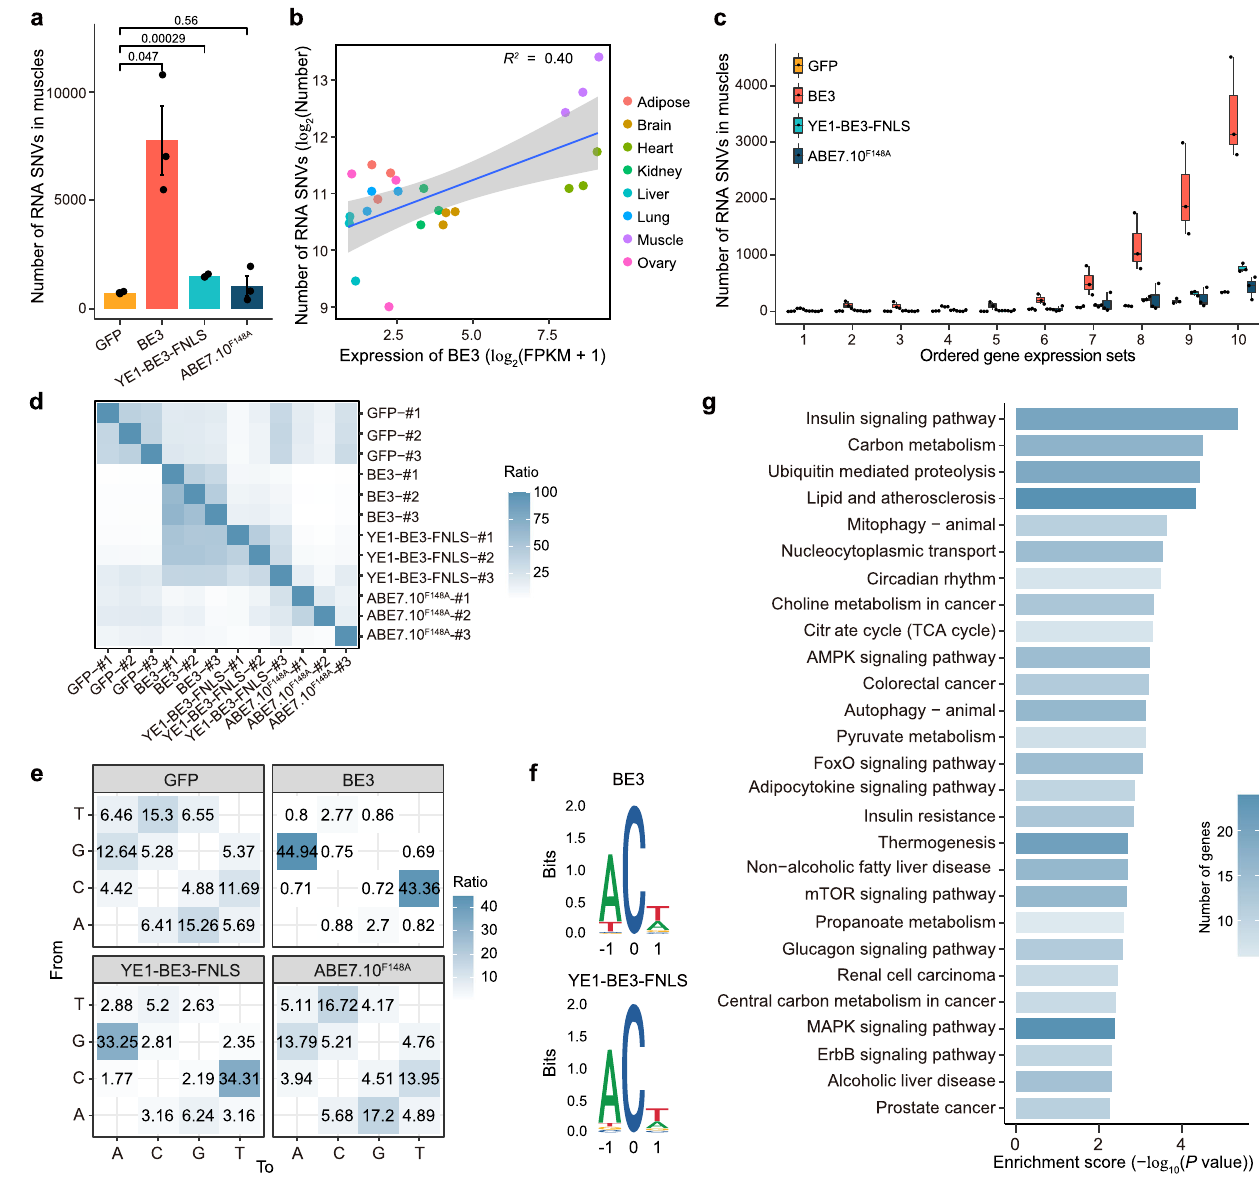
Fig.3|RNAoff-targetmutationsintheGFP,BE3,YE1-BE3-FNLSandABE7.10 F148A transgenicmice.a ComparisonofthenumbersofRNASNVsinmusclesoftheGFP, BE3, YE1-BE3-FNLS and ABE7.10 F148A transgenic mice. Data are presented as mean±SEM ( n =3). P values were calculated by two-sided unpaired t -test. b Correlationsbetweenthe numbersof RNASNVsand the expressionlevels of BE3 in diverse tissues of the BE3 transgenic mice. c Correlations between the numbers of RNASNVsand gene expression levels in the muscles ofGFP, BE3, YE1-BE3-FNLS, or ABE7.10 F148A transgenic mice. The gene expression levels were sorted by FPKM, andwereequallydividedinto10setsintheorderofexpressionlevels. d Theratioof shared RNA SNVs between any two samples from GFP, BE3, YE1-BE3-FNLS, and ABE7.10 F148A groups. The proportion in each cell is calculated by the number of